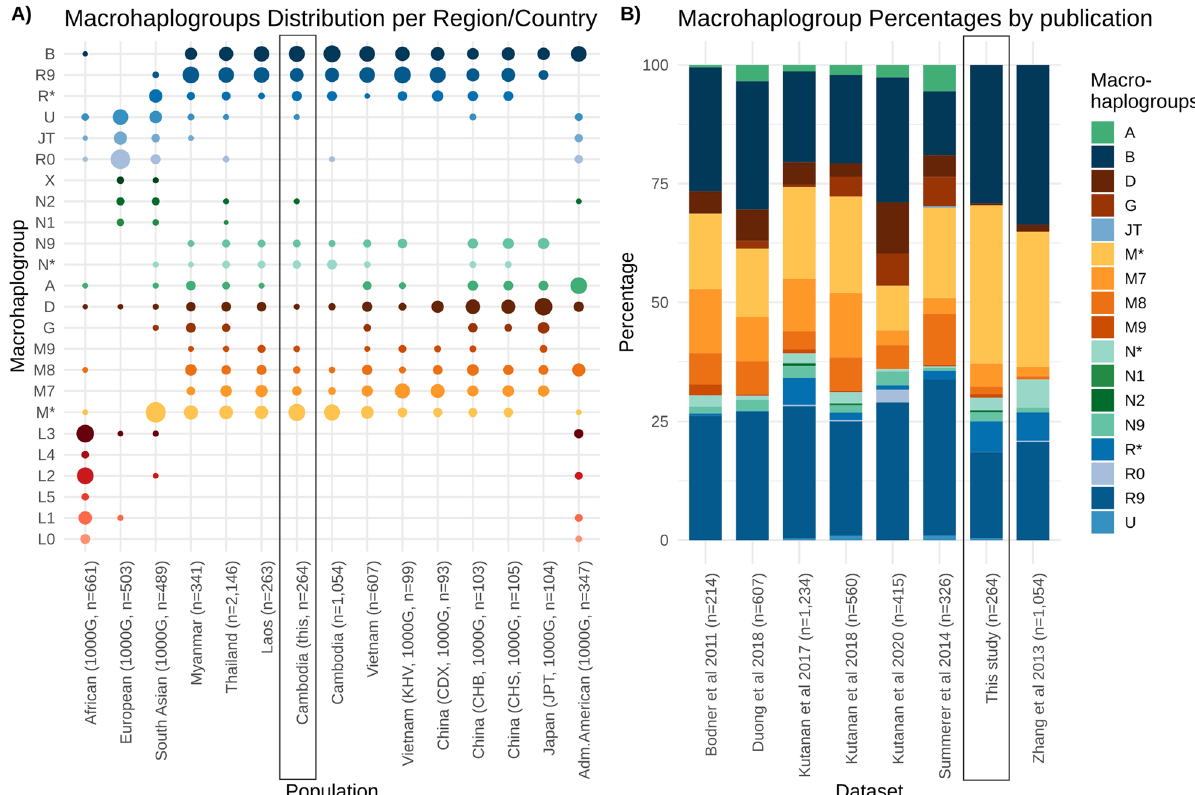
Figure 3. Haplogroup distribution in different populations/data sets. ( A ) Frequency plot of macrohaplogroups in different populations, including 1000 Genome Project data. The super populations are given for African ancestry, European ancestry, South Asian ancestry and admixed American ancestry. East Asia is reported individually as Vietnam (KHV = Kinh in Ho Chi Minh City, Vietnam), China (CDX = Chinese Dai in Xishuangbanna, CHB = Han Chinese in Beijing, CHS = Southern Han Chinese) and Japan (JPT = Japanese in Tokyo). ( B ) Haplogroup distribution by publication, Bodner et al. 16 (Laos), Duong et al. 14 (mostly Vietnam), Kutanan et al. 10–12 (mostly Thailand), Summerer et al. 18 (Myanmar), Zhang et al. 2 (Cambodia). “This study” indicates the present work’s data set. Macrohaplogroups represent M (yellow), N (green) and R (blue) ent datasets. Figure 3A includes the populations from the 1000 Genome Project, with the super populations reported, (see the 1000 Genomes Project site for details https:// www. inter natio nalge nome. org/ categ ory/ popul